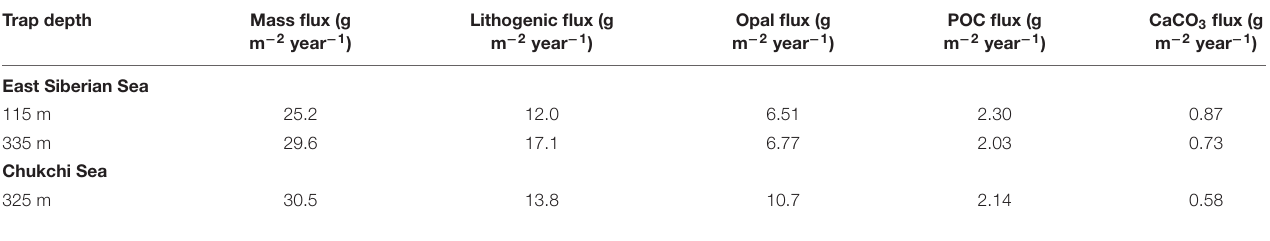
TABLE 2 | Annual POC fluxes in the western Arctic Ocean. Location Mooring Deployment